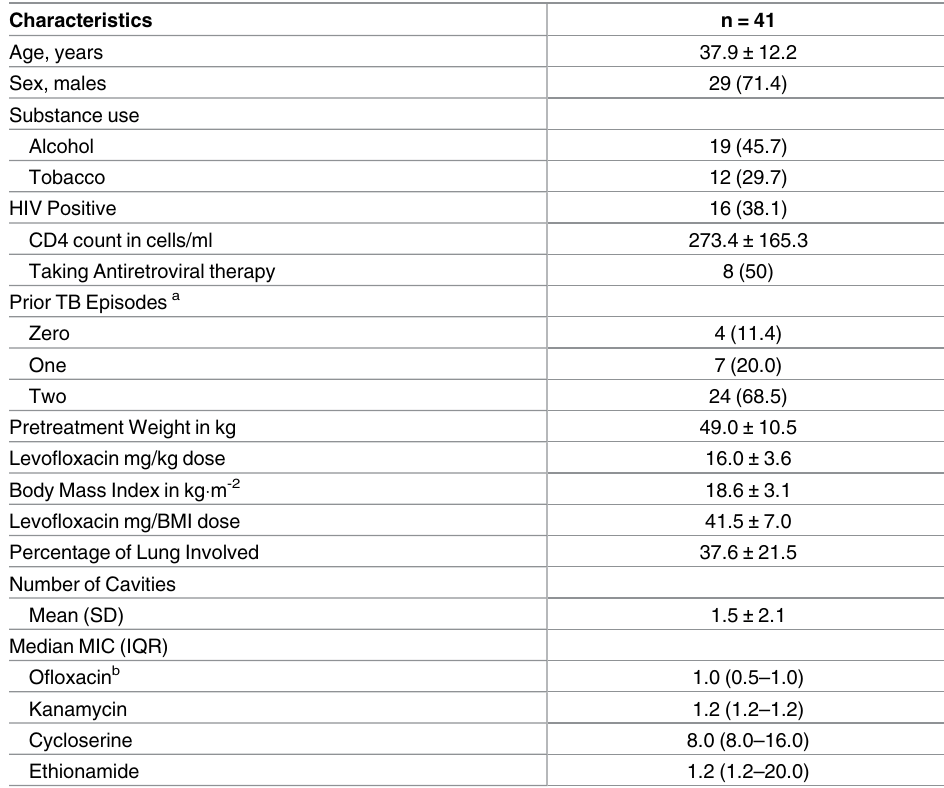
Table 2. Patient